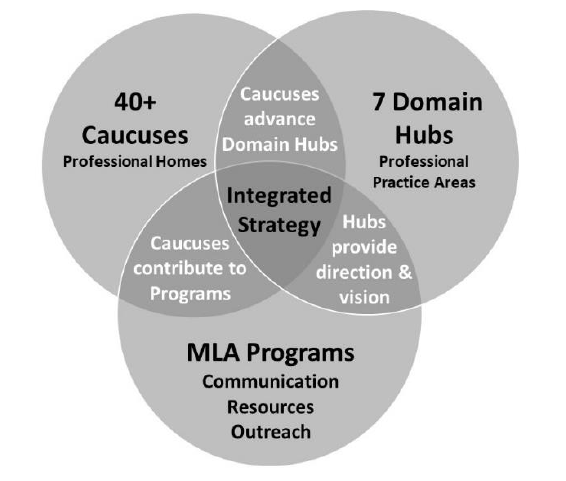
Figure 1 Collaboration, content, programming, and communication matrix. Reproduced with permission from